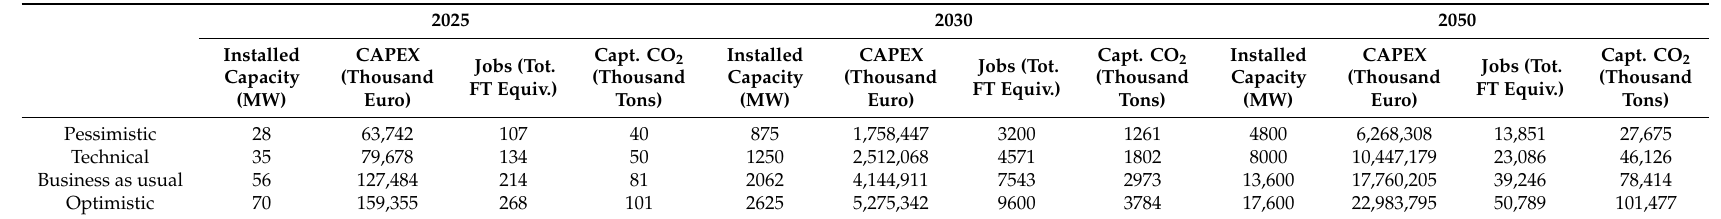
Table 7. Estimated scenarios of the PtG deployment in Spain and evolution of the main socio-economic